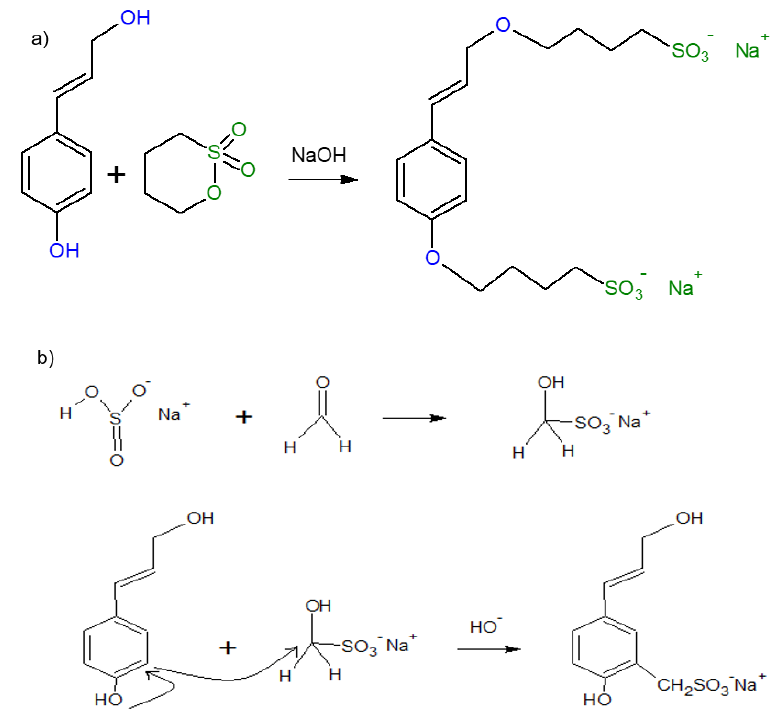
Figure 1. Reaction schemes of sulfonation of lignin ( a ) sulfobutylation of lignin via reacting phenolic and aliphatic –OH groups of kraft lignin with 1,4–butanesultone after ring-opening ( b ) sulfomethylation of lignin via formation of a sodium sulfonate methyl derivative.